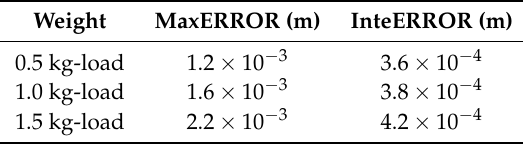
Figure 7. The tracking error of the PMA with different loads. Table 3. The tracking performance of the EPSMC with different